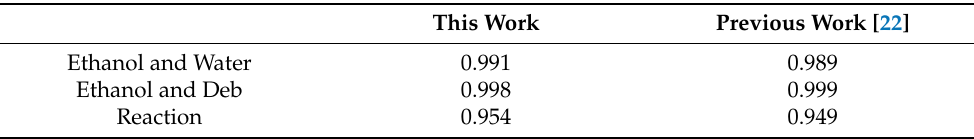
Table 3. Correlation factors attained for the breakthrough curves used for the fixed bed reactor model validation.